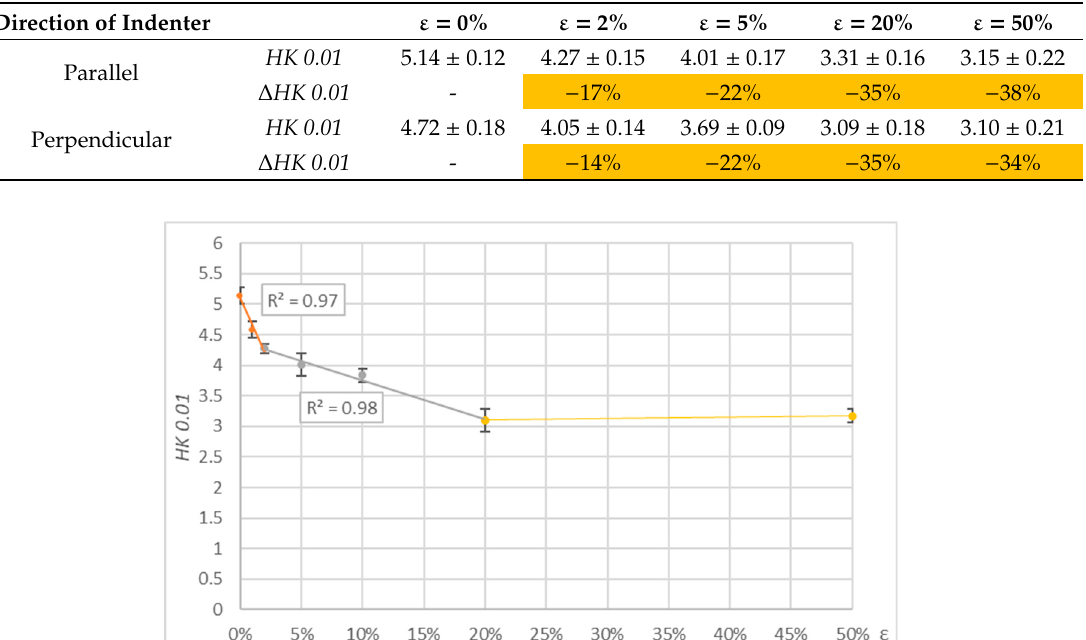
Figure 12. Results of microhardness tests for PE-HD deformed by tension.